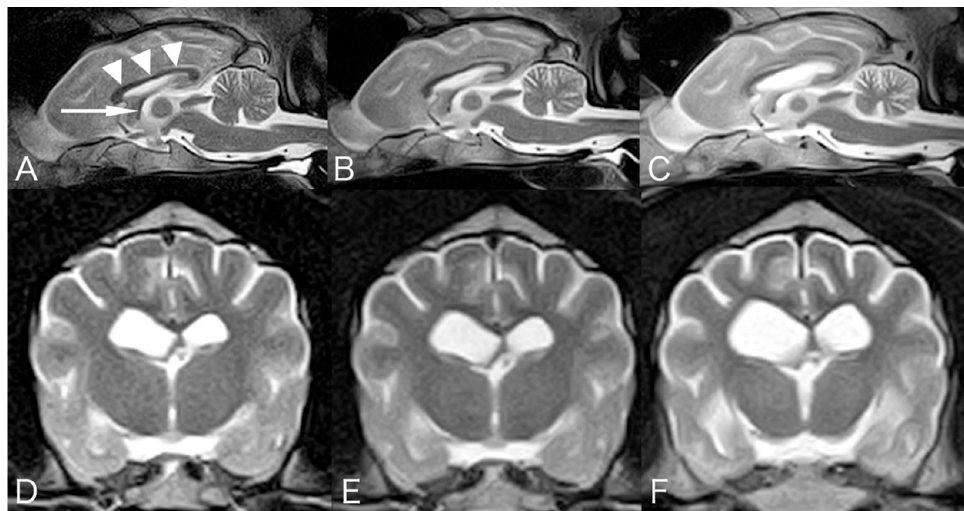
Figure 1. Mid-sagittal T2-weighted magnetic resonance images at the age of 2 years and 11 months ( A ), 4 years and 7 months ( B ), and 5 years and 8 months ( C ). Transverse T2-weighted MR images at the level of the interventricular foramen at the time of 2 years and 11 months ( D ), 4 years and 7 months ( E ), and 5 years and 8 months ( F ). Progressive symmetrical atrophy was observed in the forebrain, cerebellum, brainstem, and cranial cervical spinal cord. Corpus callosum (arrowhead) and fornix (arrow) show gradual thinning.